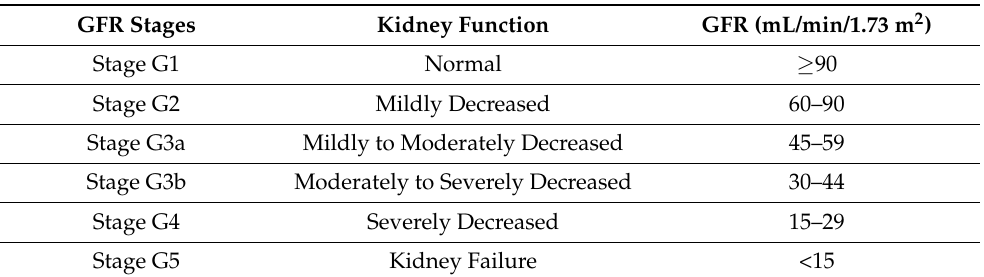
Table 2. Staging system for chronic kidney disease as per Kidney Disease Improving Global Outcomes (KDIGO)